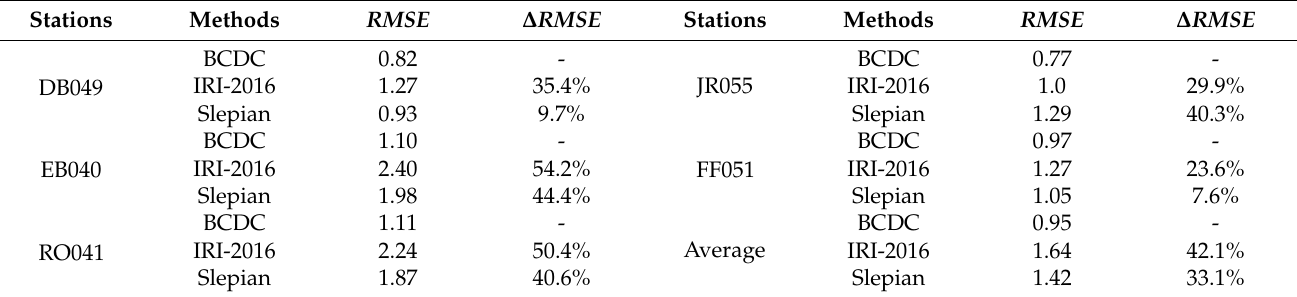
Table 2. The overall RMSE (unit: 10 11 el/m 3 ) and ∆ RMSE of the N m F 2 achieved by the three methods.